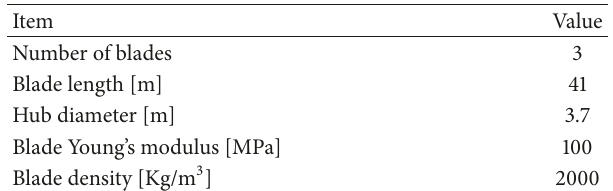
Table 1: Size of wind